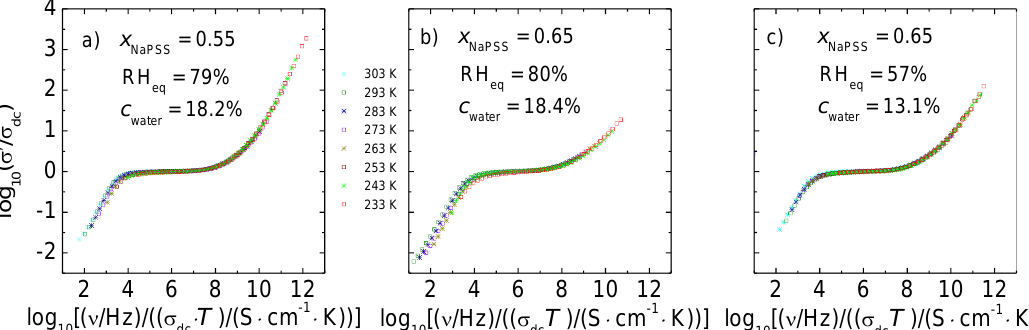
Figure 8. Conductivity spectra of Figure 5a–c scaled according to Summerfield scaling. All spectra of Figure 8 ( a – c ) were determined at constant water content as specified.